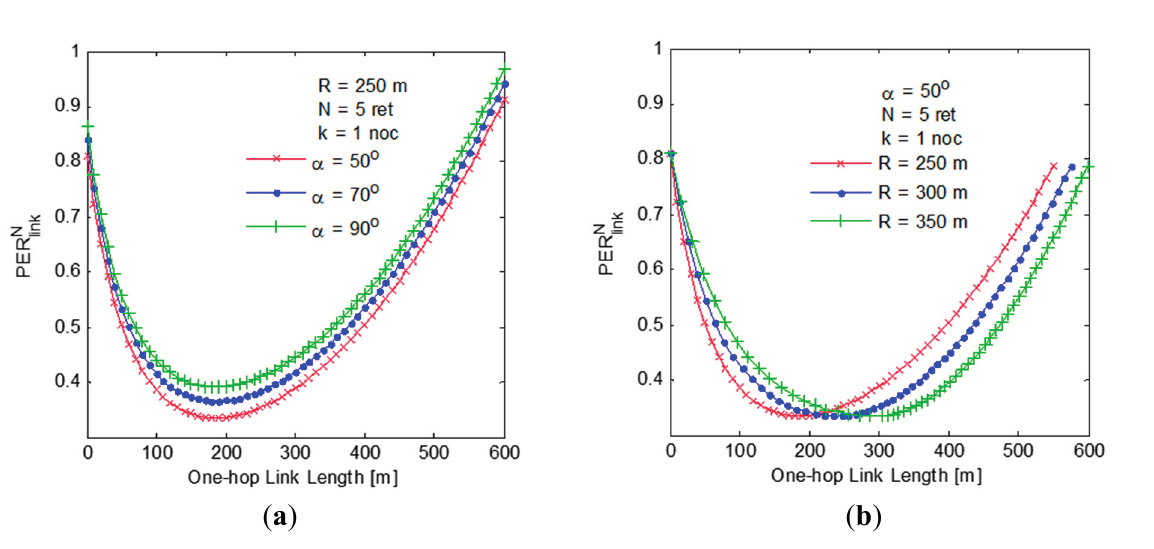
Figure 9. Impact of parameters on (cid:1842)(cid:1831)(cid:1844) (cid:3039)(cid:3036)(cid:3041)(cid:3038)(cid:3015) ( a ) and ( b ) in non-shadowing environment, ( c ) in shadowing environment and ( d ) impact of parameters on (cid:1842)